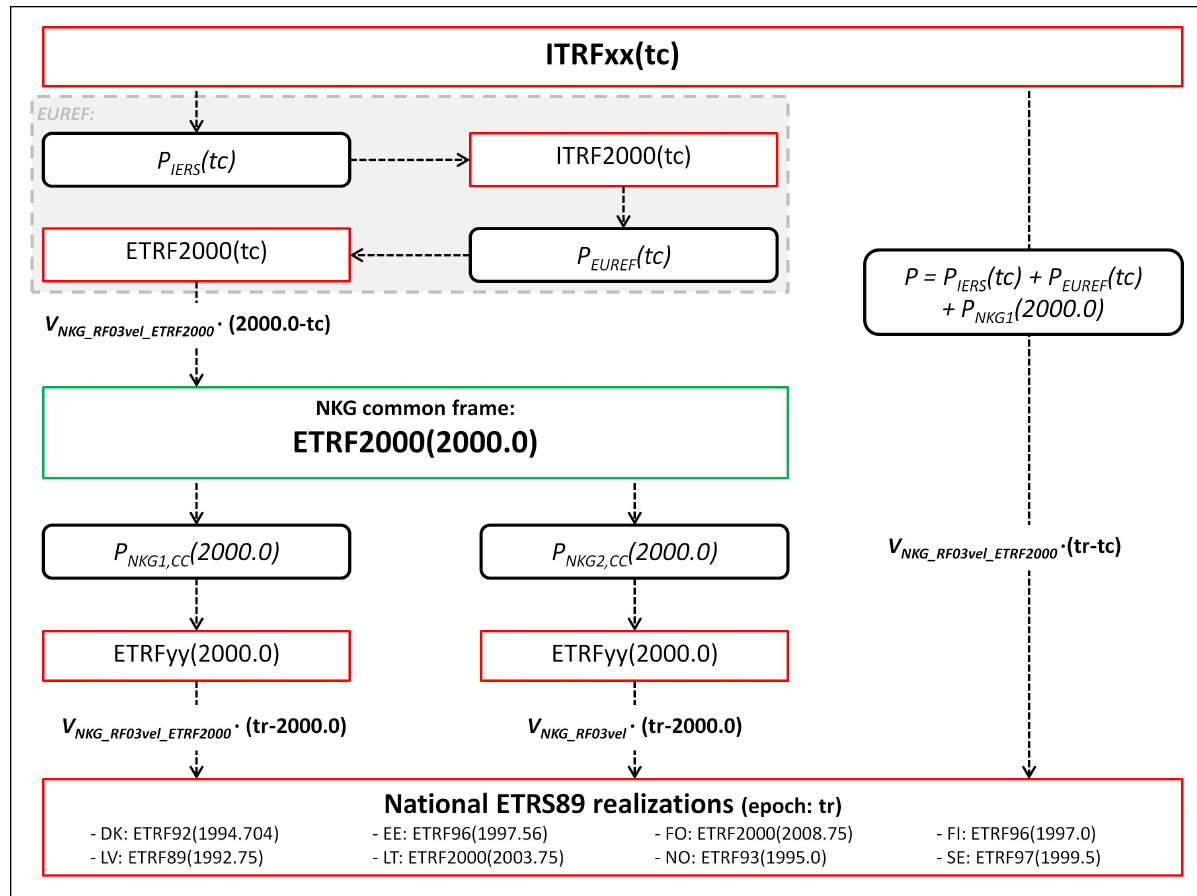
Figure 2: NKG2008 transformation from ITRFxx coordinates at an arbitrary epoch to the national ETRS89 realizations. Left-hand side path shows the step-by-step transformation and right-hand side the direct transformation with merged parameters and intraplate corrections. V NKG RF 03 vel ETRF 2000 is a correction for intraplate deformations from the re-aligned NKG RF 03 vel model and V NKG RF 03 vel from the orig- inal NKG_RF03vel model. Helmert parameters P NKG 1 and P NKG 2 are seven parameters for the similarity (Helmert) transformation at the epoch